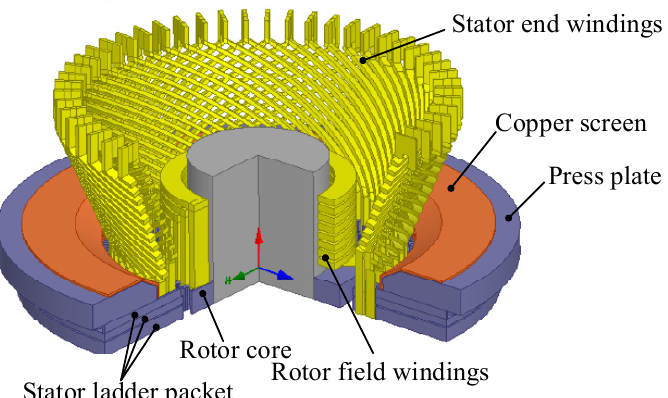
Figure 2. Physical model of the 330 million W water–hydrogen–hydrogen-cooling generator.